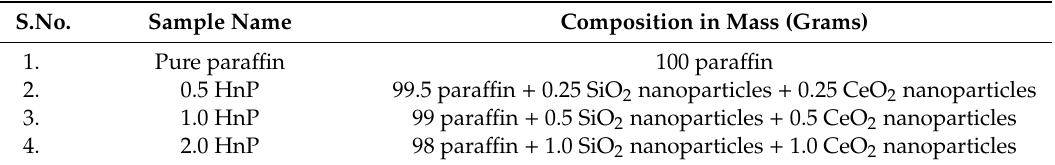
Table 2. Mass of di ff erent constituents in nano-hybrid / para ffi n